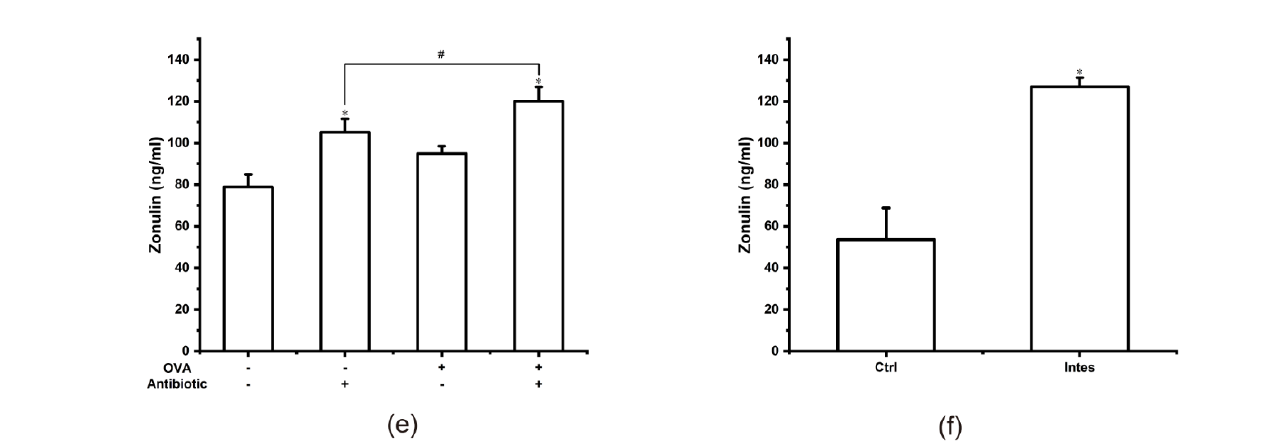
Figure 9. Dysbiosis of gut microbiota reduces tight junction proteins in jejunum tissues and increases zonulin in mice serum. ( a ) Immunohistochemical pictures and quantitative analysis of TJs in the food allergy–gut microbiota dysbiosis model. ( b ) Column graphs represent the quantitative result of (a). ( c ) Immunohistochemical pictures and quantitative analysis of TJs in the gut microbiota dysbiosis model. ( d ) Column graphs represent the quantitative result of (c). ( e ) Zonulin content in mice serum in the food allergy–gut microbiota dysbiosis model. ( f ) Zonulin content in mice serum in the gut microbiota dysbiosis model. * p < 0.05 as compared to the OVA-Antibiotic- group. # p < 0.05 as compared to the OVA+Antibiotic+